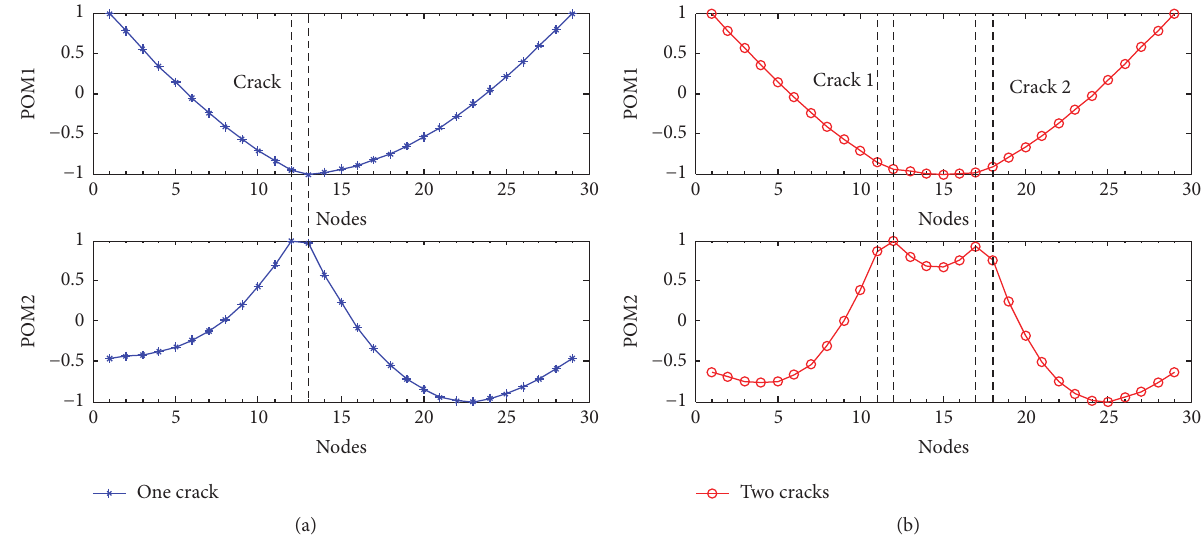
Figure 5: POMs comparison between the rotor with one crack and the rotor with two cracks. (a) One crack located in the 12th element with depth of 0.2. (b) Two cracks located in the 11th and 17th elements both with depth of 0.2.